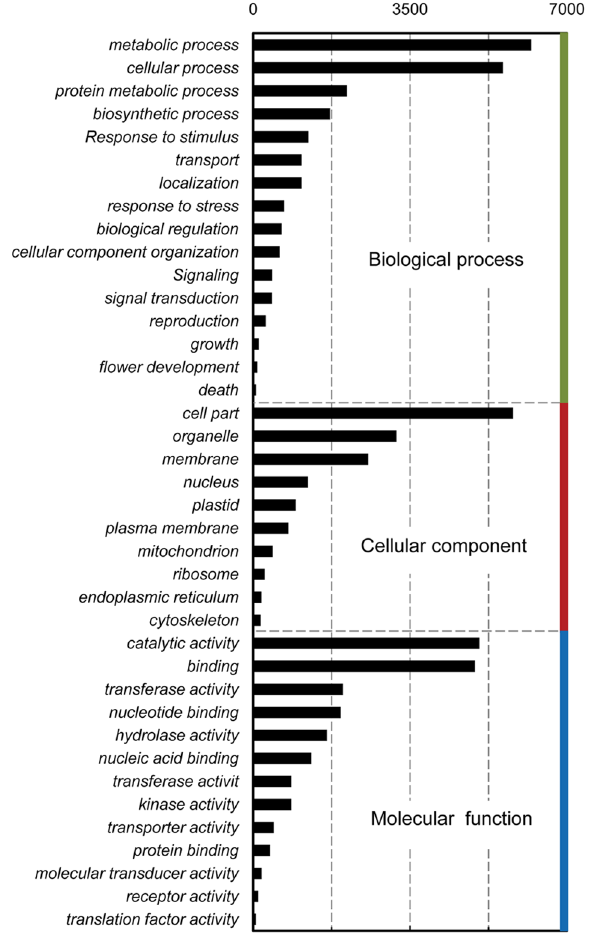
Figure 3. Functions classification of the annotated unigenes. Results are grouped by three main functional categories, Biological process, Cellular component and Molecular function. The top abscissa indicates the number of unigenes in a category. Bars show the number of assignments of protein matches to each GO term using BLASTx.